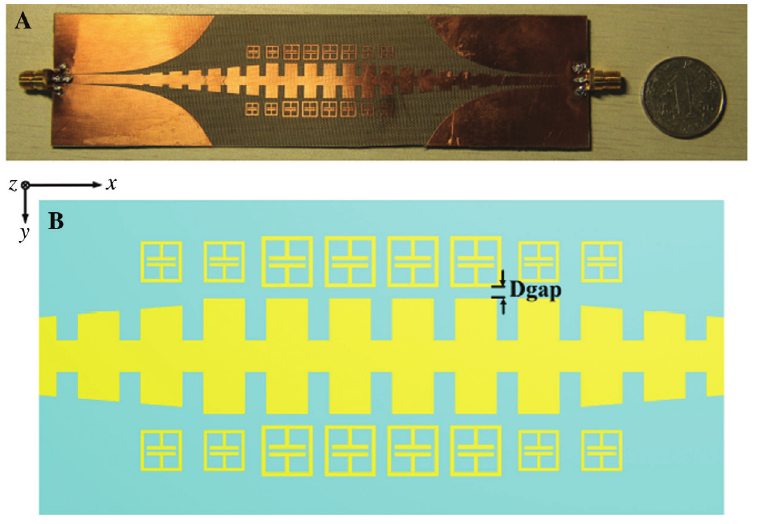
Figure 16: (A) The photograph of a fabricated sample for double-frequency rejections. (B) The schematic configuration of ELC array in the DFR SPP waveguide. Reproduced from [44] with permission.